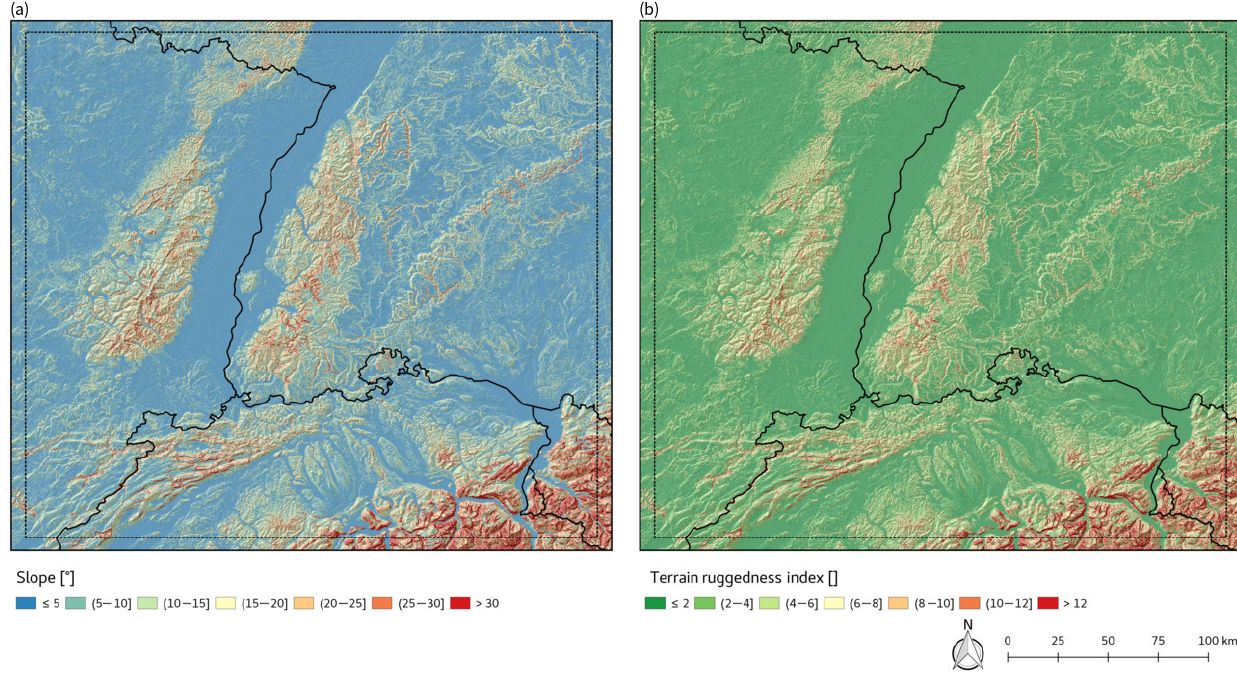
Figure 4. (a) Slope and (b) terrain ruggedness index in the target region.